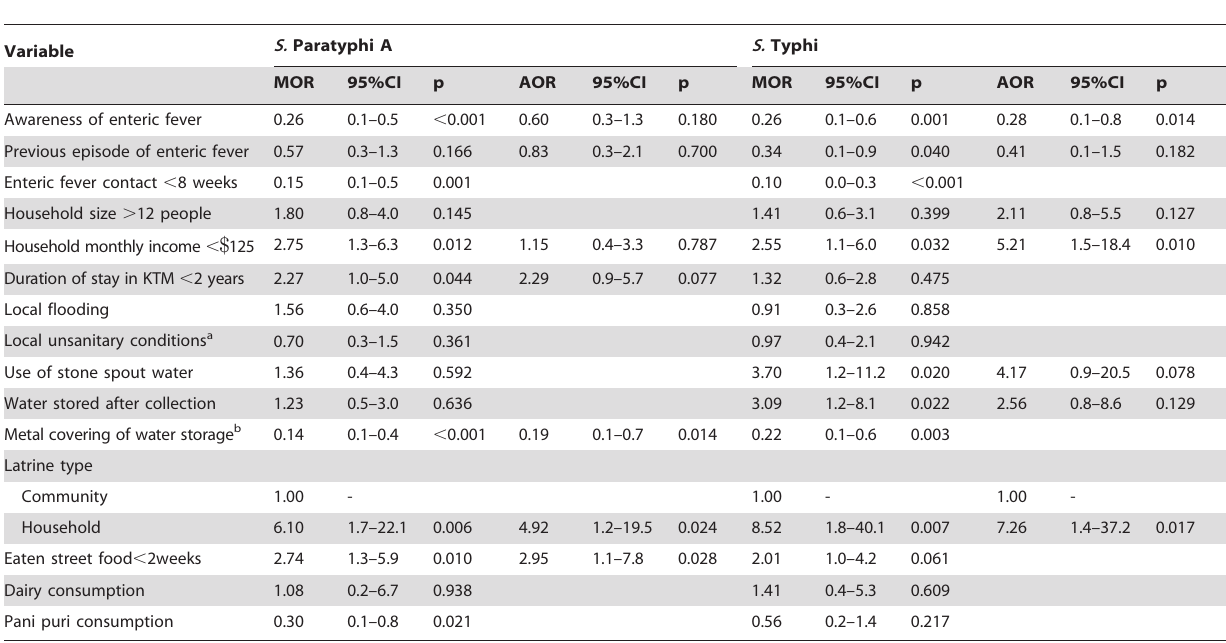
Table 3. Matched and adjusted odds ratios for various exposures for S. Paratyphi A and S. Typhi cases and matched controls in Kathmandu, Nepal, 2011.